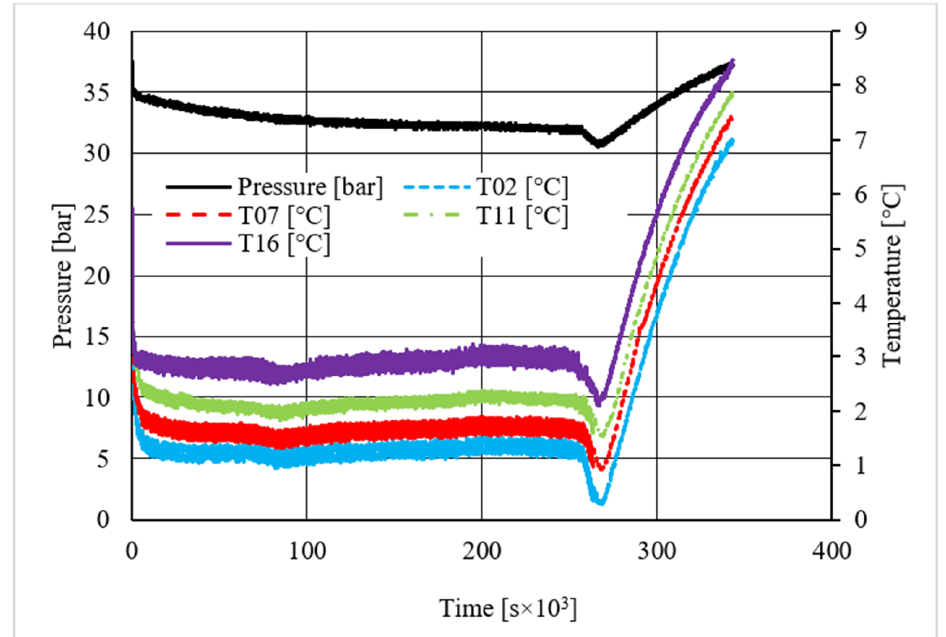
Figure 16. Pressure and temperature trend over time, measured for carbon dioxide hydrate formation in the presence of 4.23 wt.% CuSn12 powder.